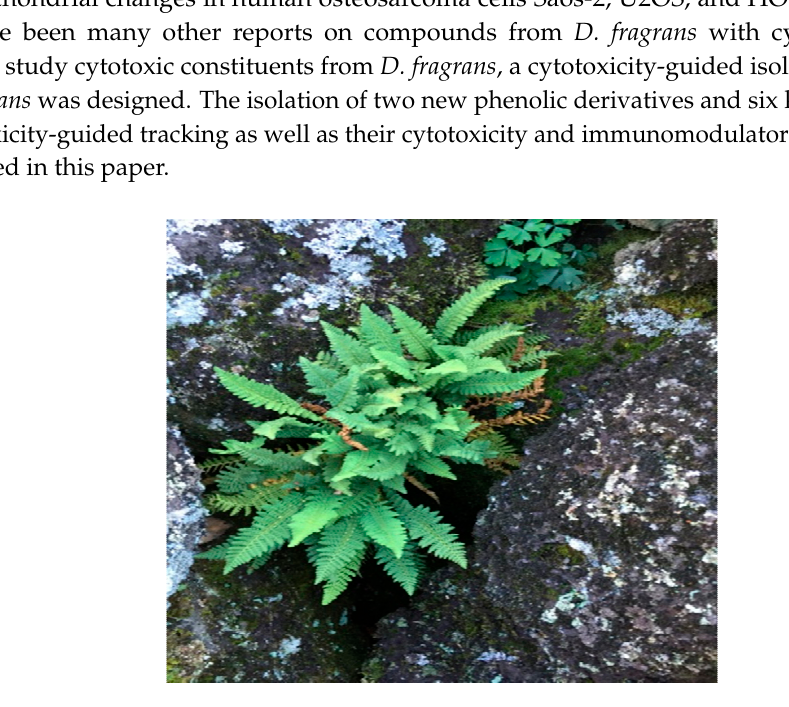
Figure 1. Dryopteris fragrans plant.